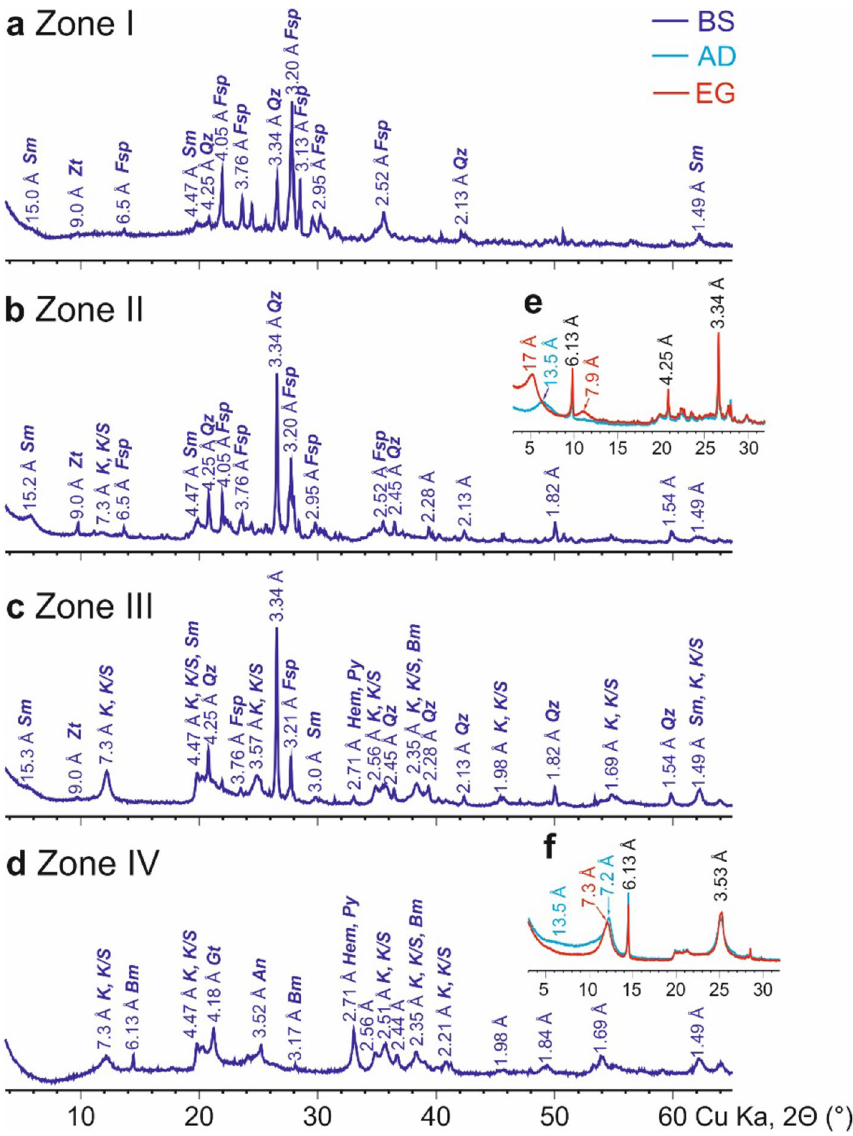
Figure 3. X-Ray diffraction patterns: ( a – d ) Bulk samples (BS) of Andosols from zones I ( a ), II ( b ), III ( c ), IV ( d ). ( e , f ) Fragments of XRD patterns from oriented ≤ 1 µm samples in air-draied (AD) and ethylene-glycole solvated (EG) states for Andosols from zones II ( e ) and IV ( f ). Crystal lattice planes in Angstroms. The main reflections represent the following minerals: Sm —smectite, Zt —zeolites, K —kaolinite, K/S —kaolinite-smectite mixed layered minerals, Bm —boehmite, Gt —goethite, Qz —quartz, Fs —feldspars, Hem —hematite, Py